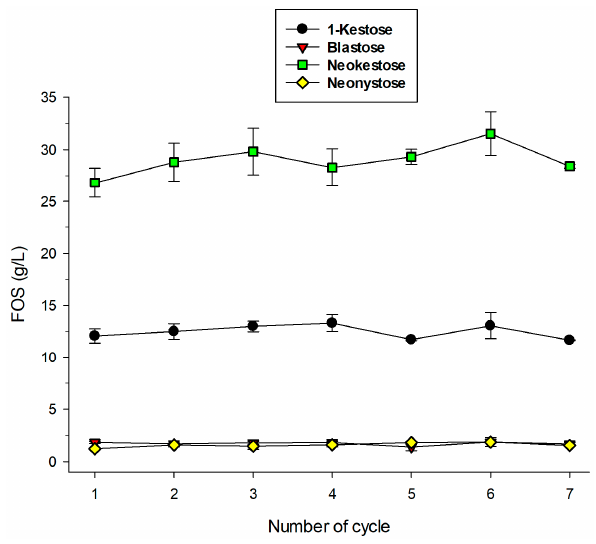
Figure 7. Operational stability of immobilized biocatalyst. Reaction conditions per cycle: 600 g/L sucrose in 100 mM sodium acetate buffer (pH 5.0), 26 h, 30 °C.